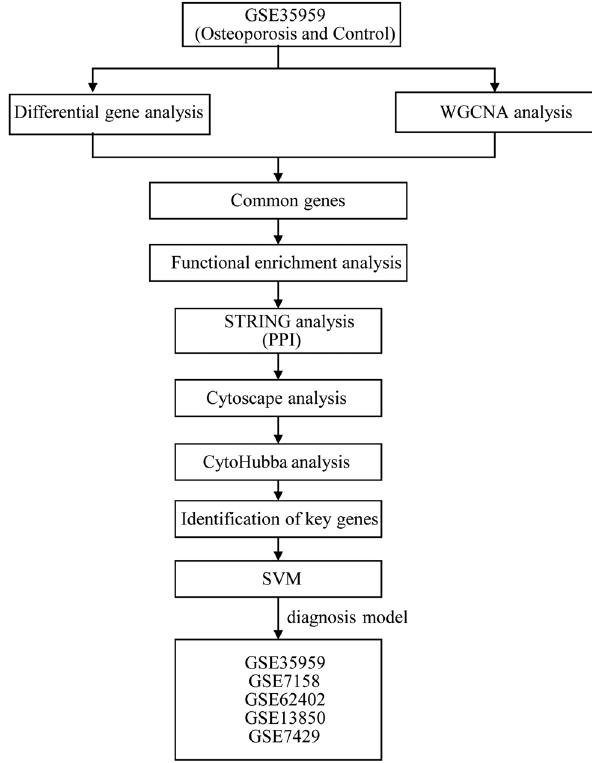
Figure 1: Work fl ow